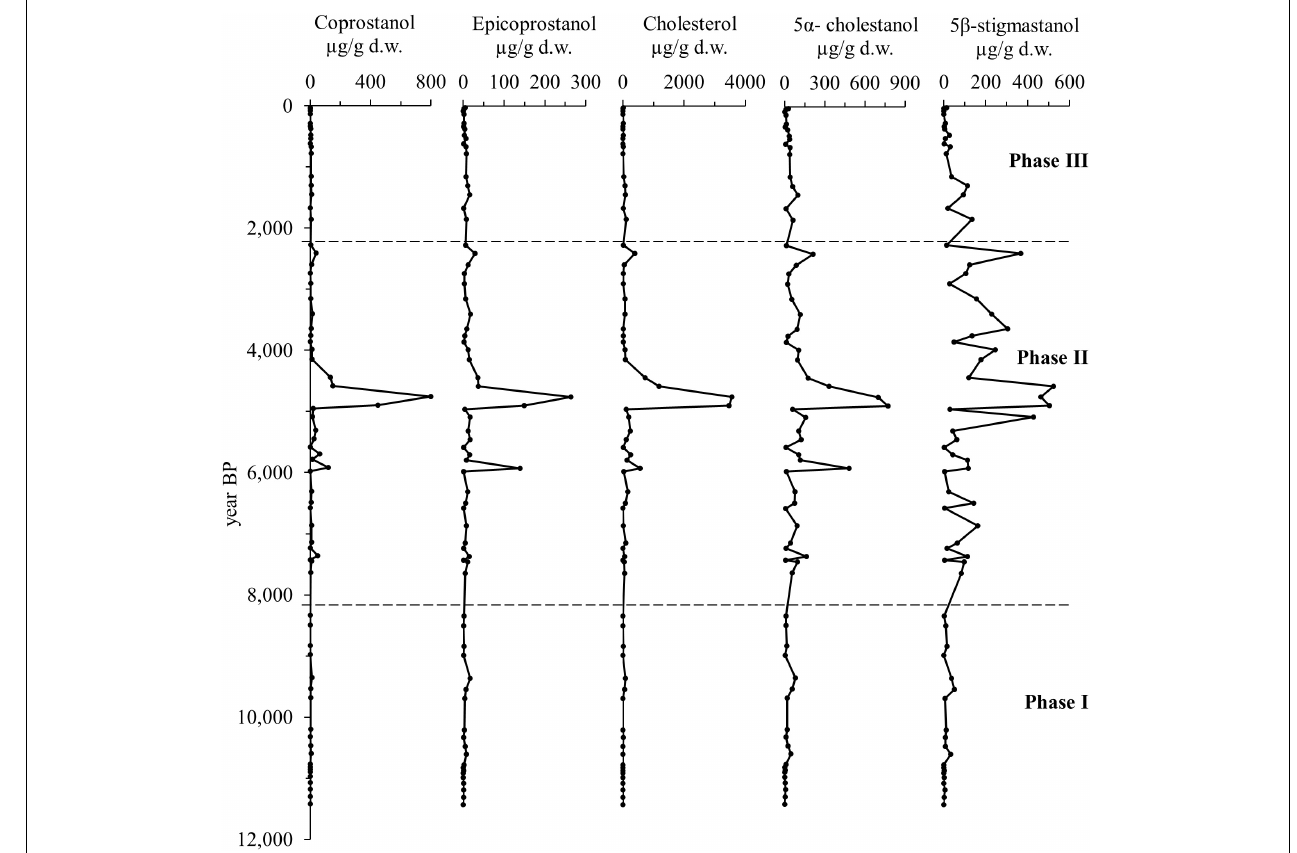
FIGURE 4 | Fecal sterol and stanol concentrations in the Lake Chatyr Kol sediments. Dashed horizontal lines indicate different time periods discussed in this